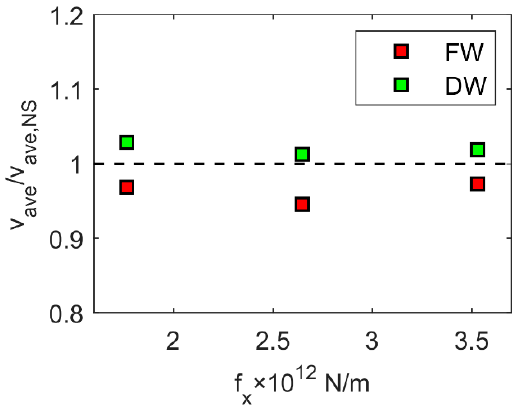
Figure 6. The simulation mean flow velocity (excluding the slip velocity) to NS mean flow velocity ratio as a function of the magnitude of flow inducing force in FW and DW simulations. The dotted line indicates the NS solution for the average flow velocity.